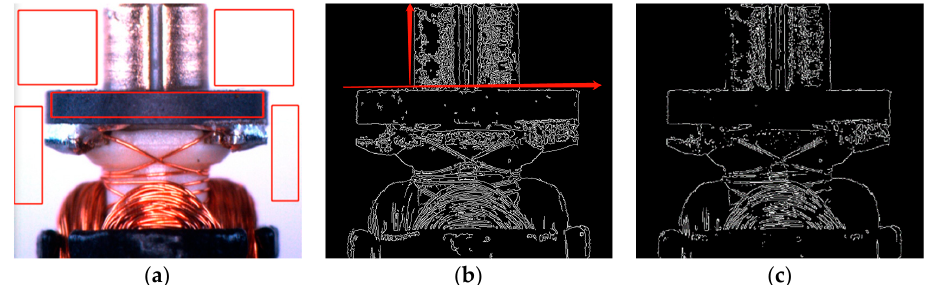
Figure 6. The original image and direct edge detection results. The ROIs have been marked by red rectangles ( a ). The two ideal baselines are marked by red lines ( b ). The noise is not reduced dramatically with the increase of the threshold, while the baseline disappears rapidly ( c ).